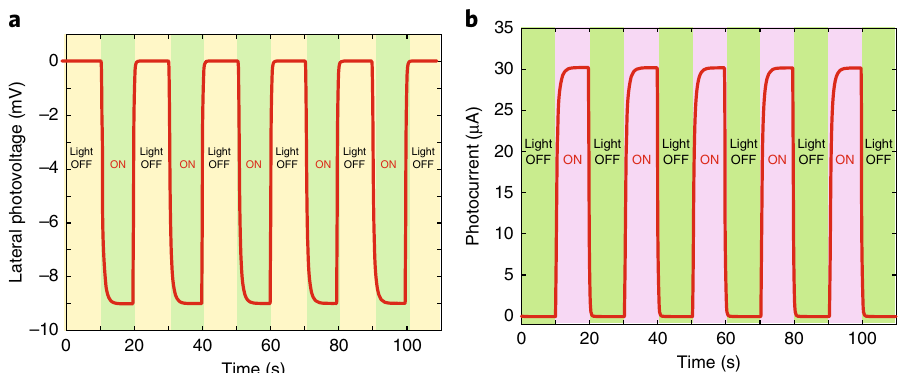
Fig. 4 Generated photovoltage and photocurrent. a Under light illumination of 19,000 lx, a lateral photovoltage of approximately − 9.0 mV was generated between the two electrodes. b The photocurrent under light illumination of 19,000 lx. As the light was turned OFF, the photocurrent was 0 μ A, and this value was ~29.7 μ A when light with an intensity of 19,000 lx was ON